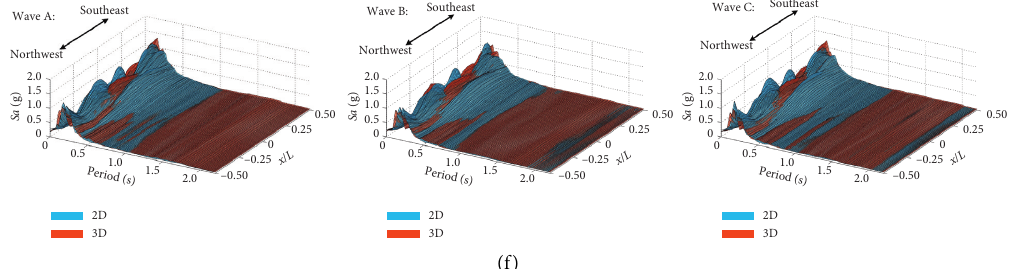
Figure 10: Acceleration response spectra with the damping factor of 5% on (a) Slice 1; (b) Slice 2; (c) Slice 3; (d) Slice 4; (e) Slice 5; (f) Slice 6. 00.20.40.60.81.01.2 ) ( g S a